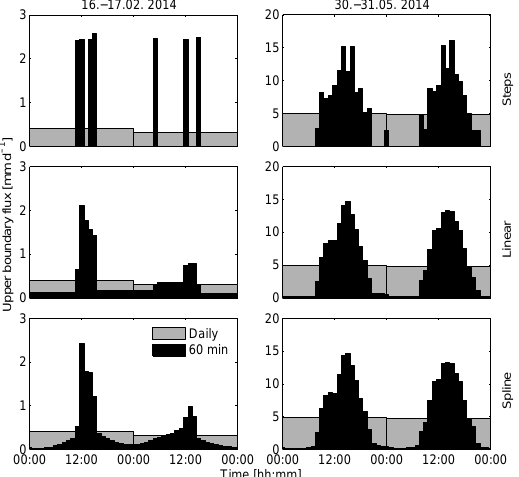
Figure 4. Derived potential evapotranspiration rates from data shown in Fig. 2 with temporal resolutions of 1 day or 10min, re- spectively. Steps: original step interpolation scheme; linear: linear interpolation scheme; spline: cubic Hermitian spline interpolation scheme. Note different scales on ordinates for the step scheme be- tween Figs. 4 and